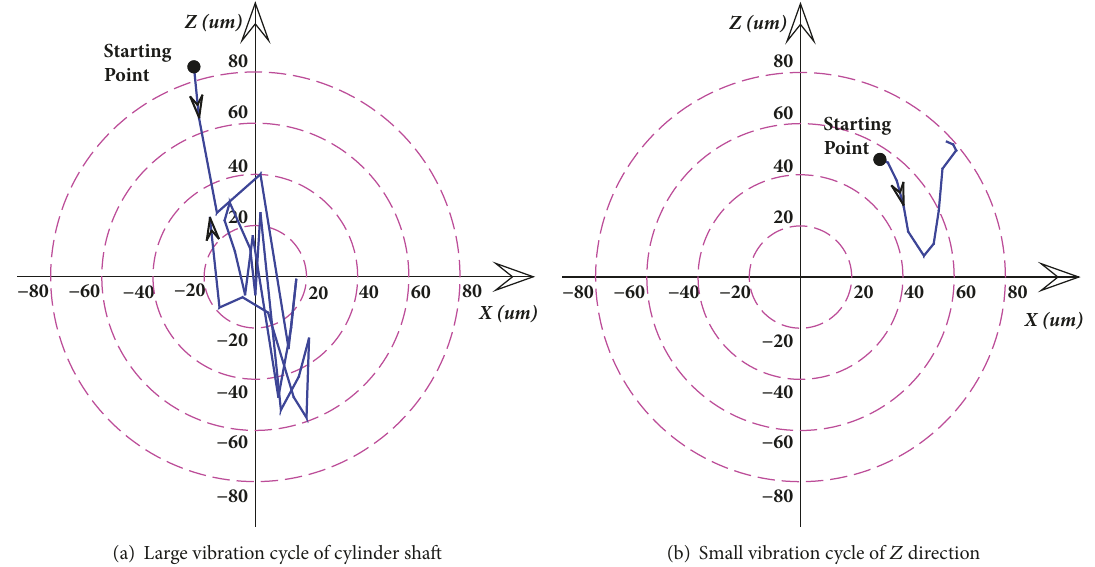
Figure 16: Axis trajectory and variation of no-load cylinder rotation.